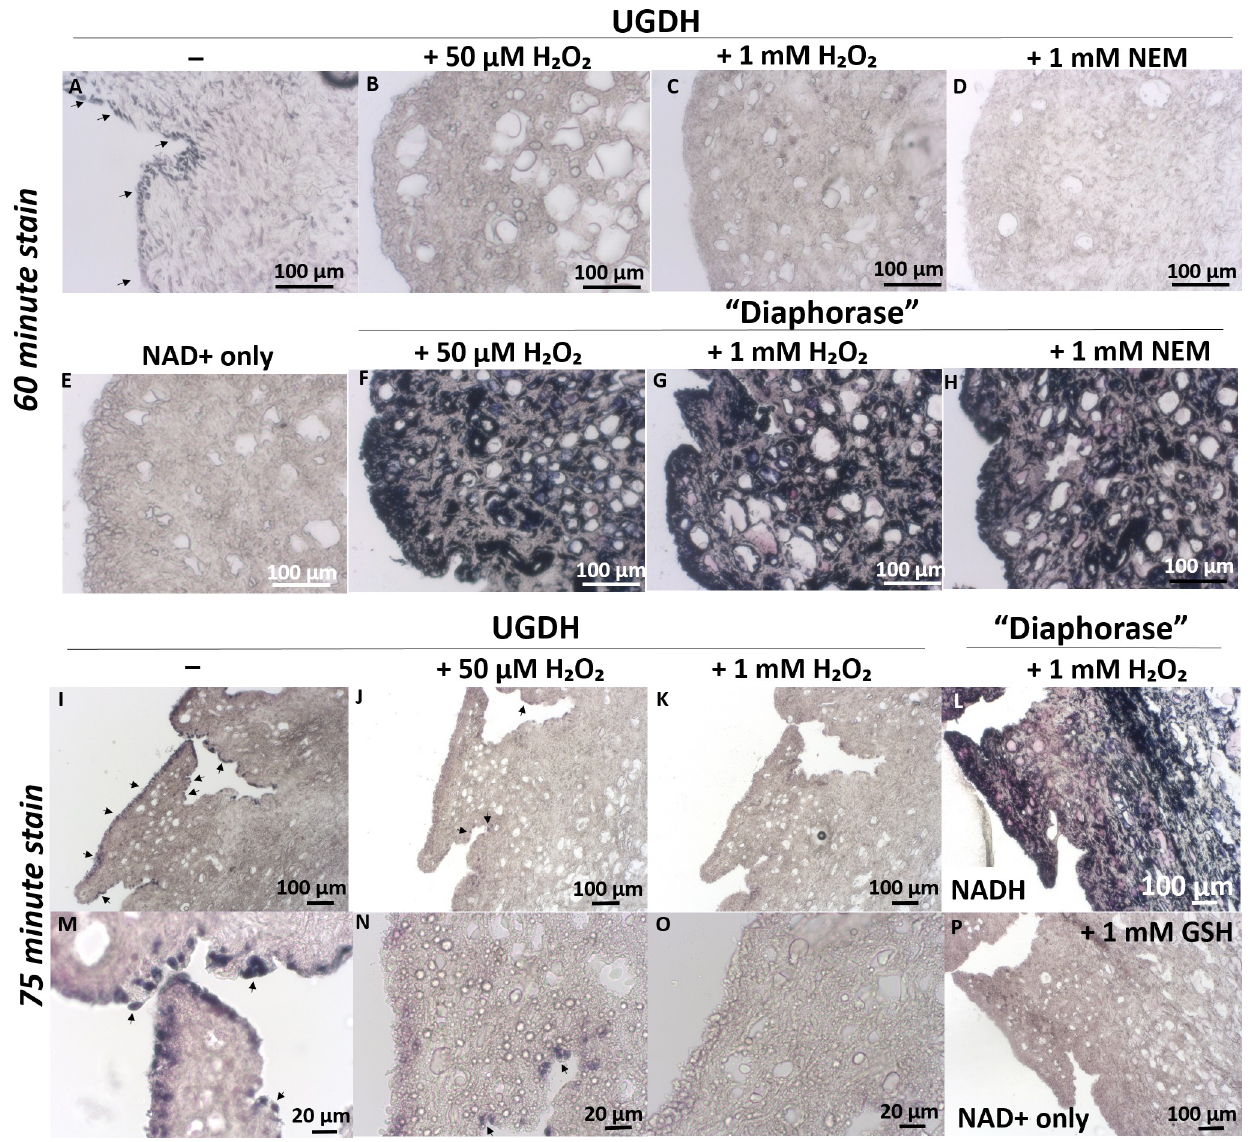
Fig 6. Peroxide and NEM inhibited UGDH but not diaphorase enzyme staining activity in synovial lining cells from an injured rabbit knee. In serial synovial cryosections from a New Zealand White male rabbit knee 1 week post-microdrilling, UGDH staining (A, I, M) was inhibited by NEM (D) and by peroxide in a dose-dependent manner (B, C, J, K, N, O) but “diaphorase” was insensitive to thiol modifying inhibitors (F, G, H, L). UGDH and “diaphorase” enzyme histostaining was carried out per standard conditions, in the presence of peroxide or NEM, or with NAD+ only ( ± 1 mM GSH) as indicated, with a 60 or 75 minute incubation at 37˚C. UGDH enzyme staining was completely suppressed by NEM (D) and more suppressed by 1 mM peroxide (C, K, O) than 50 μ M peroxide (B, J, N). Scale bars are 20 μ m or 100 μ m, as